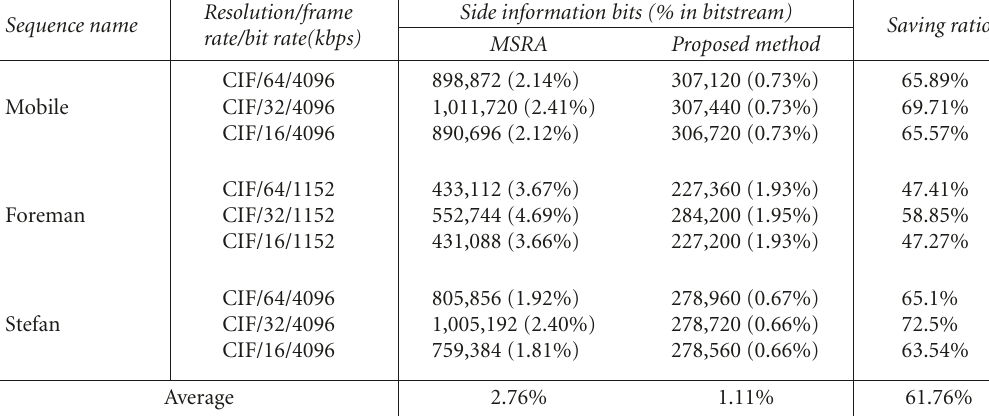
Table 3: Side information bit overhead versus GOP